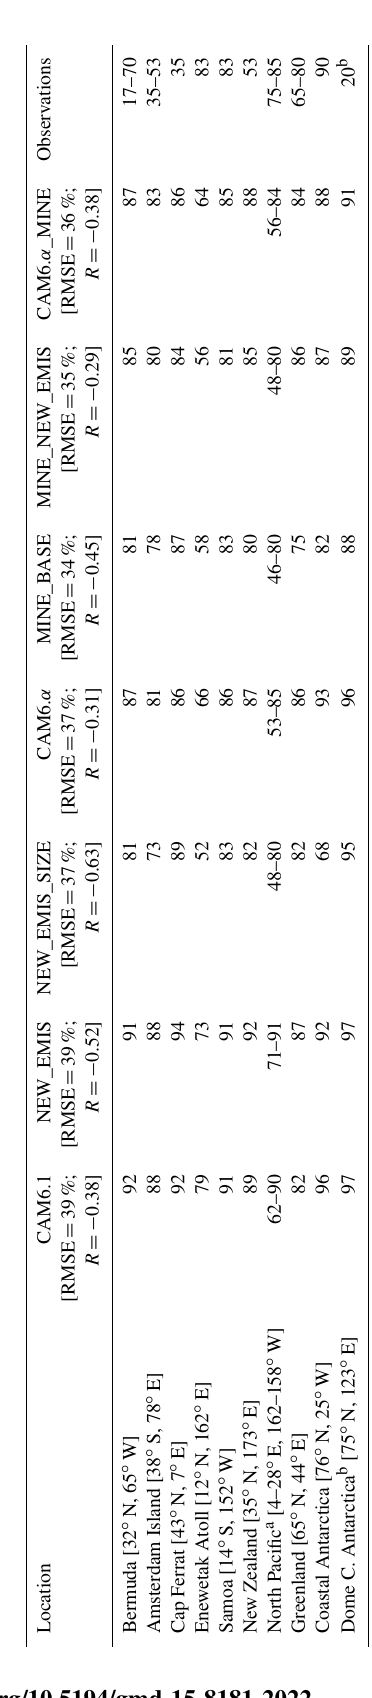
Laguna: 28 ◦ N, 17 ◦ W; Santa Cruz Tenerife: 29 ◦ N, 16 ◦ W; and Puerto Rico: 18 ◦ N, 67 ◦ W) the mass size distribution from CAM6. α becomes evidently worse than from